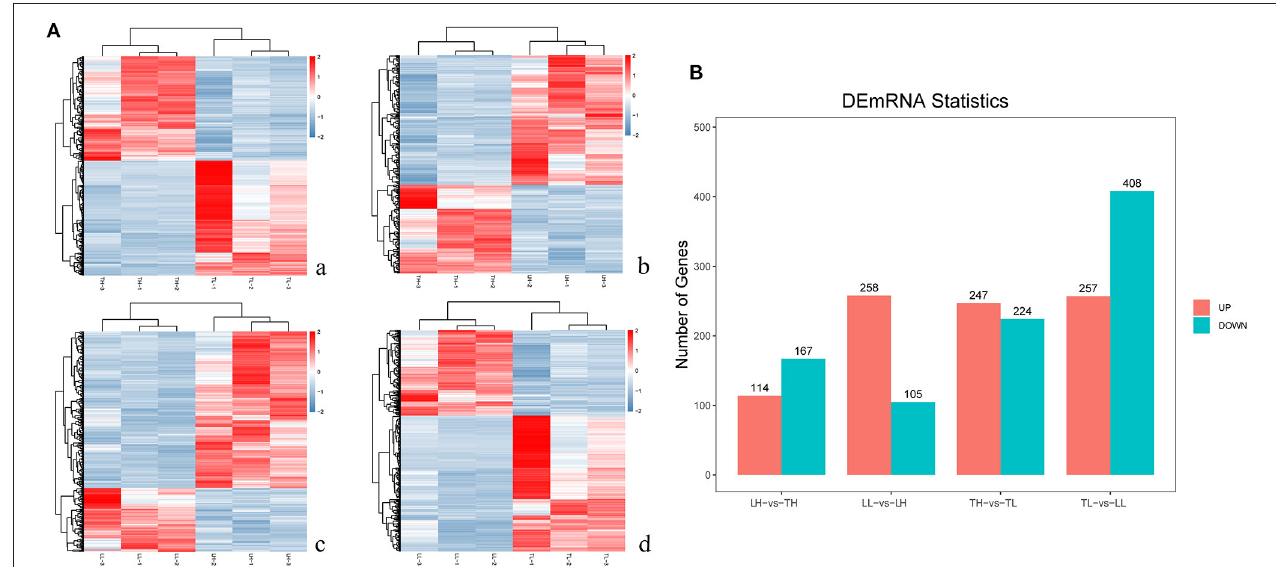
FIGURE 2 | mRNA expression results among the four groups by RNA-seq. (A) The heatmap shows the relative expression patterns of DEmRNAs among the four groups. Each column represents a sample, and each row represents the expression levels of a single mRNA in various samples. The color scale of the heat map ranges from blue (low expression) to red (high expression). a. Heatmap of mRNA for Tibetan pigs raised in highland (TH) and Tibetan pigs raised in lowlands (TL). b. Heatmap of mRNA for TH and Landrace pigs raised in highlands (LH). c. Heatmap of mRNA for LH and Landrace pigs raised in lowlands (LL). d. Heatmap of mRNA for TL and LL. (B) The histogram shows the number of DEmRNAs identified among the four groups.